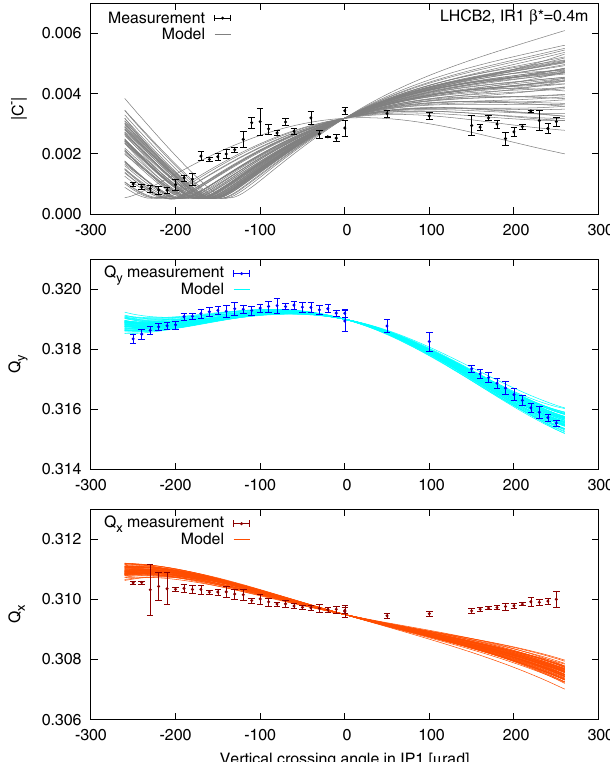
FIG. 7. Measured and modeled variation of tune and coupling in LHC beam 2, during a scan of the vertical crossing angle in IR1 ¼ 0 . 4 at β (cid:1) IP 1